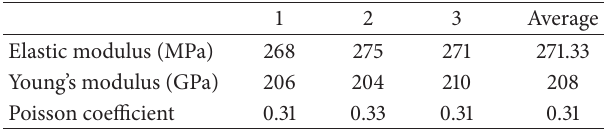
Table 2: Mechanical properties of the ribbed steel sheet obtained in tensile tests.